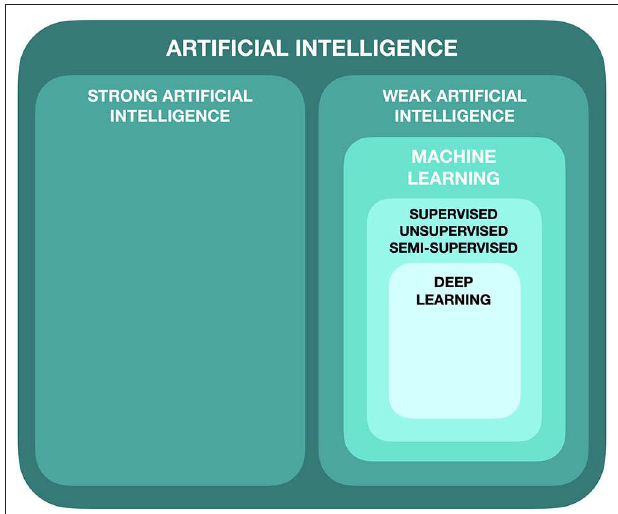
FIGURE 1 | Subdivisions of artificial